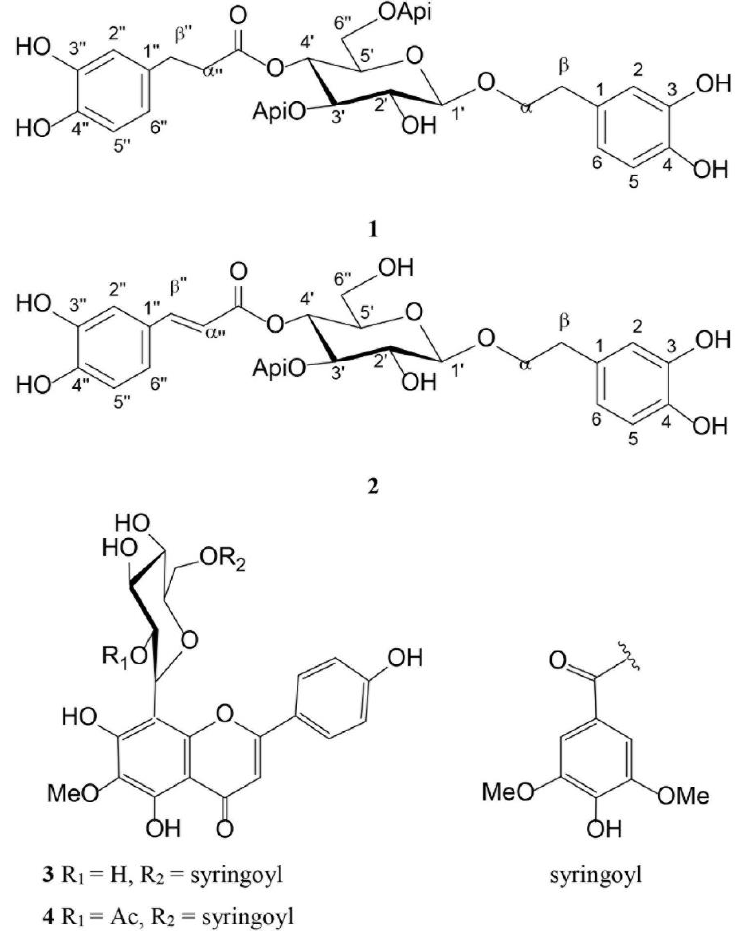
Figure 1. Structures of the compounds isolated from Haberlea rhodopensis aerial parts. ( 1 ) Mycono- side; ( 2 ) calceolarioside E; ( 3 ) hispidulin 8- C -(2- O -syringoyl- β -glucopyranoside; ( 4 ) hispidulin fsali8- C -(6- O -acetyl-2- O -syringoyl- β -glucopyranoside).